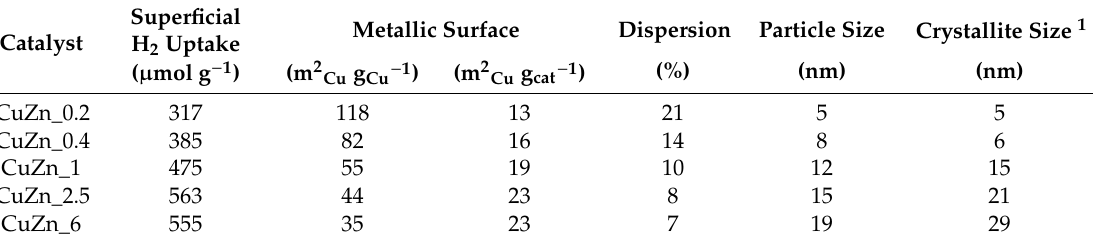
Table 3. Metallic properties of CuZn_X catalysts, as determined from N 2 O